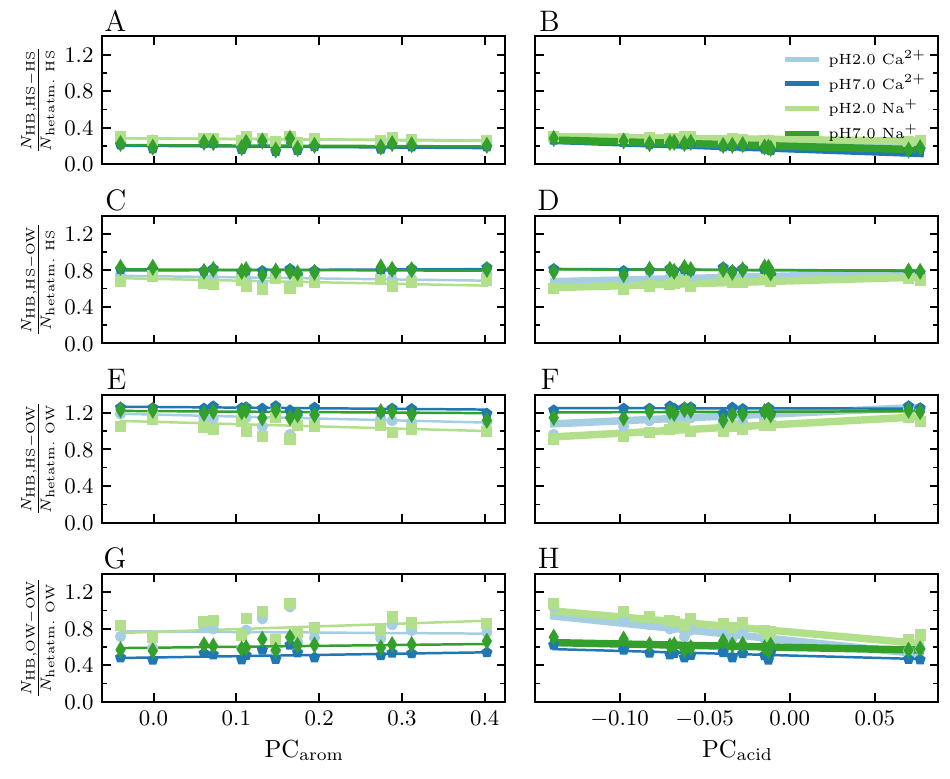
Figure 9. Number of hydrogen bonds of the humic substances models normalized by the number of heteroatoms as a function of their PC arom and PC acid . Number of hydrogen bonds between humic substances normalized by the number of heteroatoms of humic substances ( A , B ). Number of hydrogen bonds between humic substances and water molecules normalized by the number of heteroatoms of humic substances ( C , D ) and normalized by the number of heteroatoms of water molecules (same as the number of water molecules) ( E , F ). Number of hydrogen bonds between water molecules normalized by the number of water molecules ( G , H ). Each point represents the average over four independent simulations with error bars representing the standard